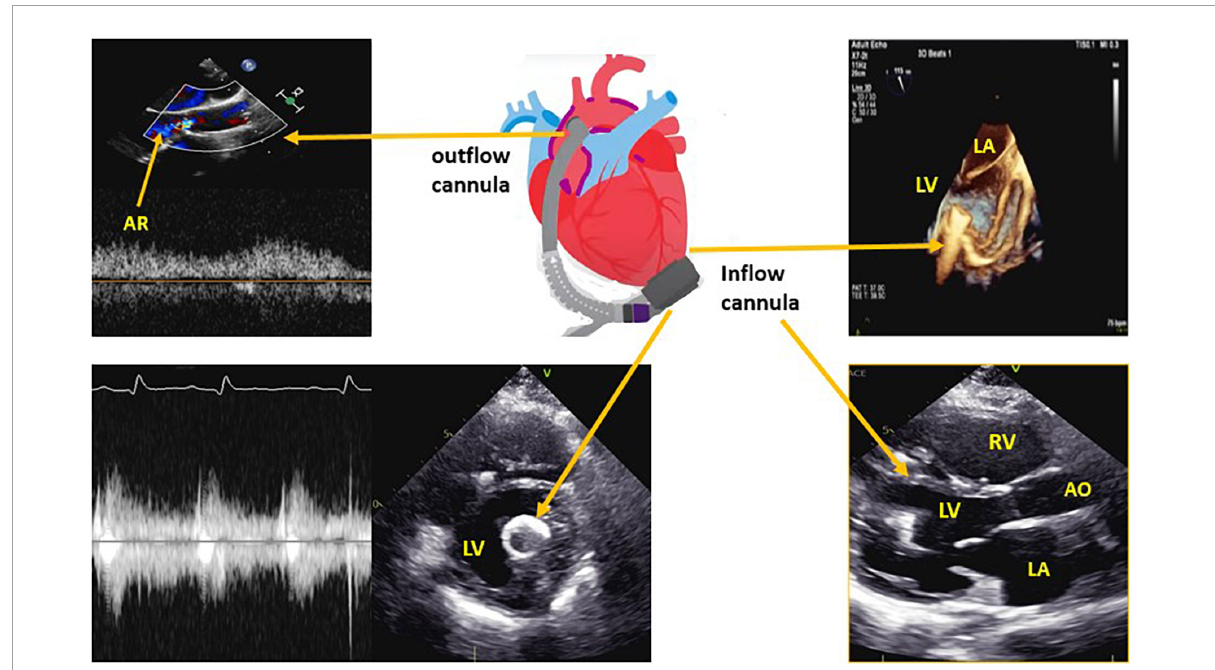
FIGURE1 Left ventricular assist device (LVAD) structure with the corresponding echocardiographic images for the inflow cannula and outflow cannula. LV, left ventricle; LA, left atrium; RV, right ventricle; AR, aortic regurgitation.